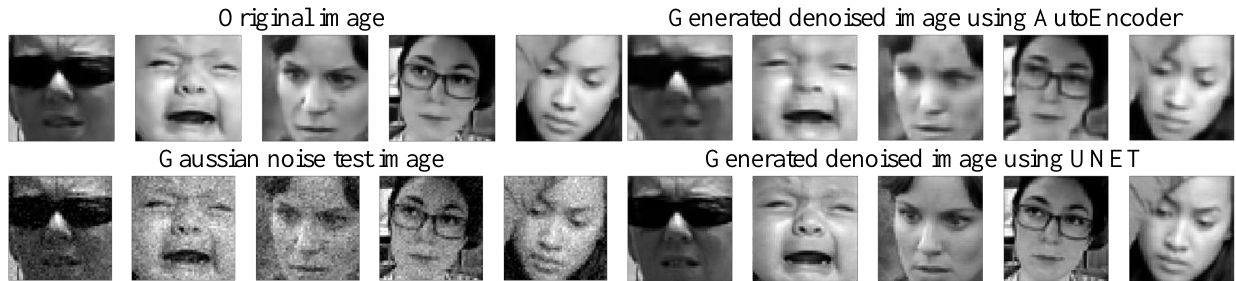
Figure 7. FER2013 images (a) original image (b) Gaussian noise image with noise factor of 0.05 (c) denoised